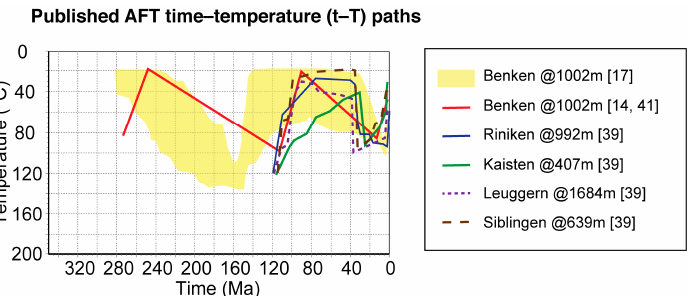
Figure 3. Comparison of published apatite fission track (AFT) thermal histories from selected boreholes within the Jura fold-and-thrust belt (FTB; for location of boreholes, see Figure 2). All paths represent the best-fit inverse model with the exception of Benken, which is either a forward model (red line [14,41]) or a good-fit solutions envelope (yellow area, [17]). All previously published AFT data were obtained by the external detector method or by the multi-grain population method.